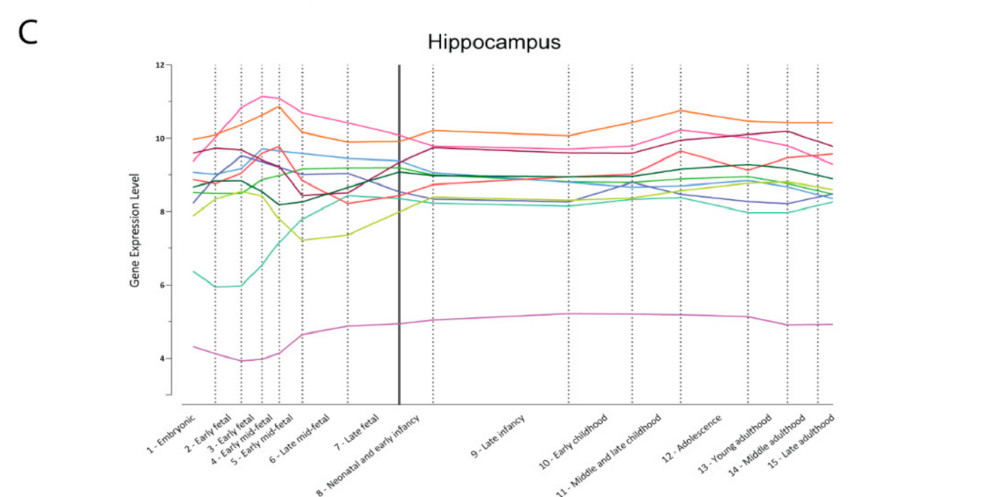
Figure 2. Proteins involved in the regulation of neurite elongation. ( A ). PPI network of the best-characterized components of the Rho GTPase signaling RAC1, RHOA, and CDC42 realized with Cytoscape [269]. Boxes represent the nodes (proteins), while the arrows indicate the edges (interactions). GTPases are reported in green, their GEFs and GAPs in red, their effectors in blue, and actin-binding or actin-modifying proteins in purple. Edges can be either “activatory” (arrowheads) or “inhibitory” (blunted lines). The “neurite elongation” node represents the phenotypic outcome. Acronyms are spelled out in the text. ( B , C ). Expression trajectories of ID-related genes in the human dorsolateral prefrontal cortex ( B ) and hippocampus ( C ). Quantile normalized gene-level expression values (log 2 transformed) inferred from Human Brain Transcriptome database [270] were plotted against logarithmic age in days. The pattern was summarized by the smoothed curves of the expression values. Dashed lines divide periods of development and the solid line separates prenatal from postnatal periods. Individual genes are color-coded, legend in panel ( C